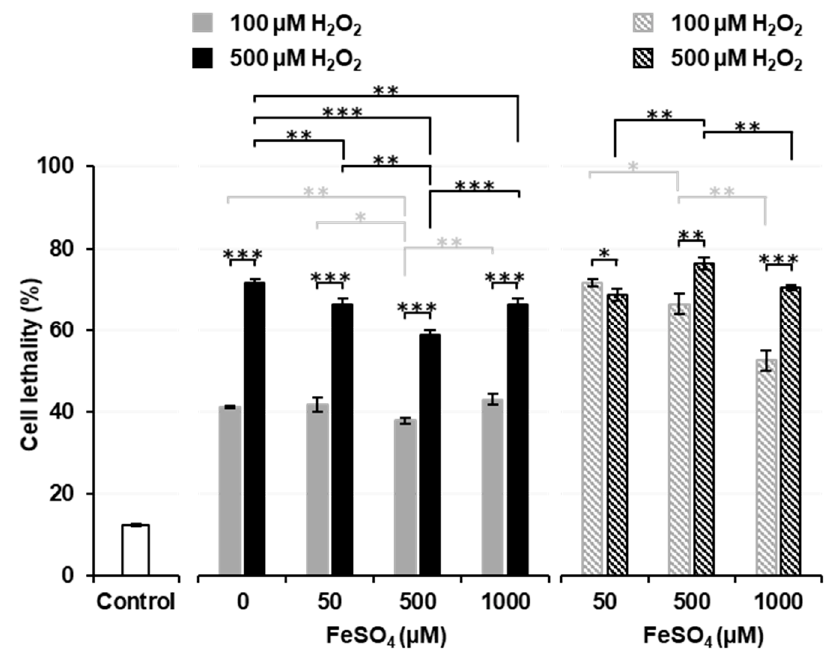
Figure 3. Effects of the pre-incubation of cells with FeSO 4 on cytotoxicity induced by the administration of H 2 O 2 . Neither H 2 O 2 nor FeSO 4 was added to the control sample, i.e., the cell suspension was just incubated. Solid columns show the results of Experiment 3, i.e., H 2 O 2 was added after the pre-incubation with or without FeSO 4 . Striped columns show the results of Experiment 4, i.e., H 2 O 2 was added after the removal of FeSO 4 from pre-incubated samples. Columns and error bars indicate the average and SD of three experiments. Significant differences are indicated in the figure as *, **, and ***, which correspond to p < 0.05, p < 0.01, and p < 0.001, respectively. The striped columns in Figure 3 show the results of Experiment 4, i.e., H 2 O 2 was added after the removal of FeSO 4 from pre-incubated samples. When extracellular Fe 2+ ions were removed before the addition of H 2 O 2 (striped columns), cell lethality was higher than in samples treated with the same dose of H 2 O 2 with remaining extracellular Fe 2+ ions (solid columns). When the results of 100 µM H 2 O 2 experiments (gray striped columns)